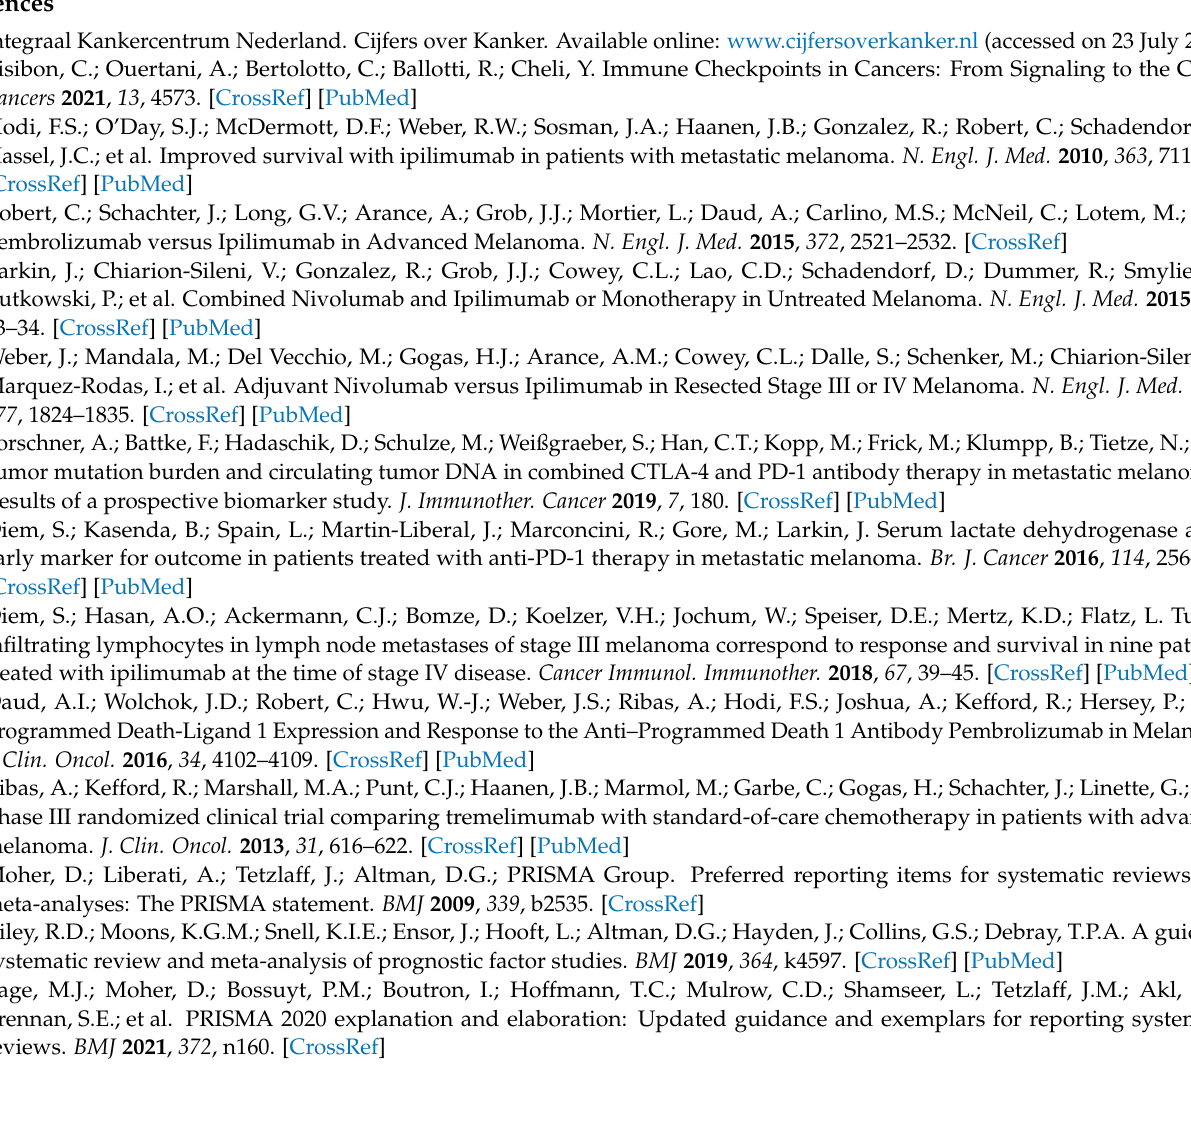
assessment, Table S2: Outcomes of all included reports, Table S3: Peripheral blood biomarkers that were studied for anti-CLTA-4 therapy, Table S4: Peripheral blood biomarkers that were studied for anti-PD-1 therapy, Table S5: Peripheral blood biomarkers that were studied for mixed cohorts, Table S6: Peripheral blood biomarkers that were studied for combination therapy, Table S7: Tumor biomarkers that were studied for anti-CLTA-4 therapy, Table S8: Tumor biomarkers that were studied for anti-PD-1 therapy, Table S9: Tumor biomarkers that were studied for mixed cohorts, Table S10: Tumor biomarkers that were studied for combination therapy, Table S11: Fecal biomarkers that were studied for all